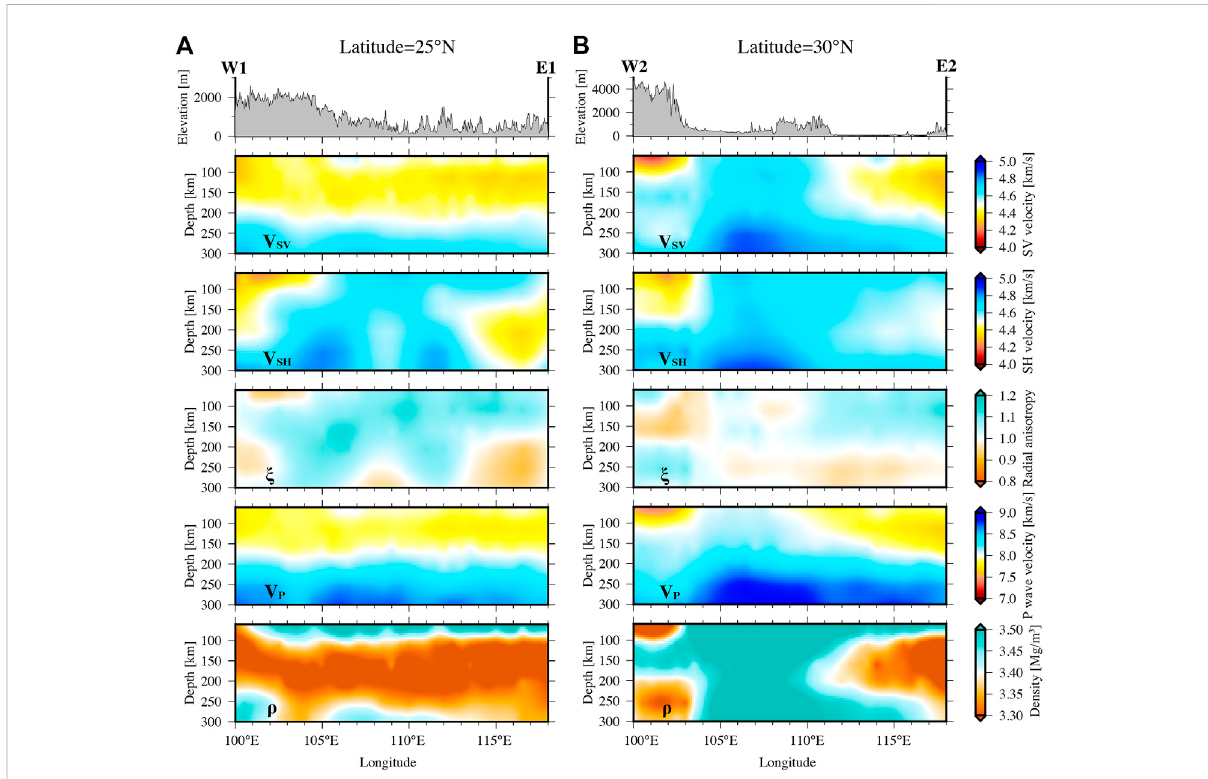
FIGURE 12 Vertical Cross-sections of the mantle component of SREM-SC along pro fi les (A) W1-E1 at 25 ° N and (B) W2-E2 at 30 ° N indicated in Figure 11A. Topography is plotted above each cross-section, and the red lines are the approximate border of the main tectonic units. YC, Yangtze Craton; CB, Cathaysia Block; TP, Tibetan Plateau; NCC, North China Craton; QDO, Qinling-Dabie